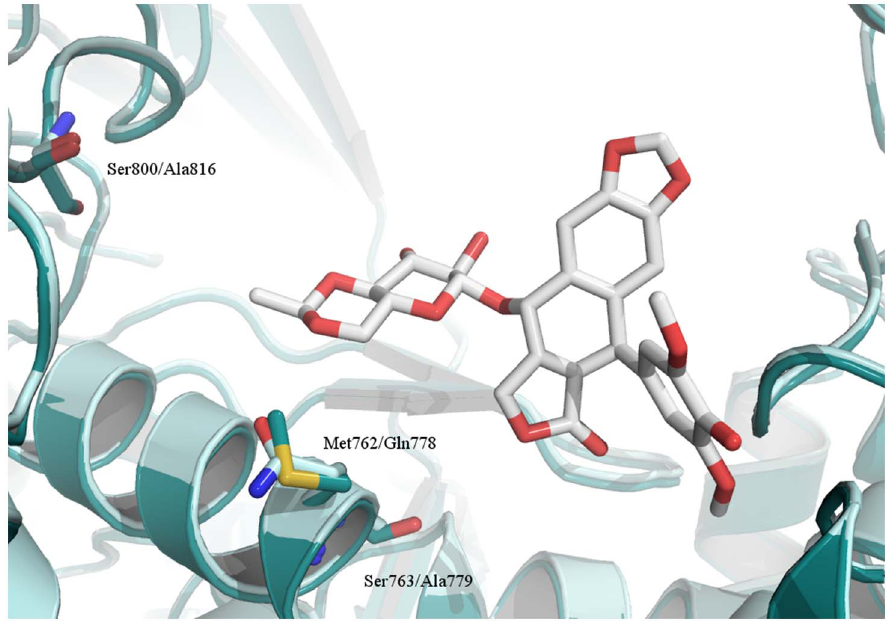
Fig. 3. Possible residues to be targeted by Top2 a versus Top2 b -selective molecules. Superimposition of Top2 a homology model (dark cyan) and Top2 b crystal structure (light blue) [34], shown in cartoon representation. Residues in the etoposide binding pocket which differ between the Top2 a and Top2 b isoform are indicated as sticks (residue names: Top2 a /Top2 b ). Etoposide pose from the Top2 b crystal structure (stick representation, carbons white) shown for